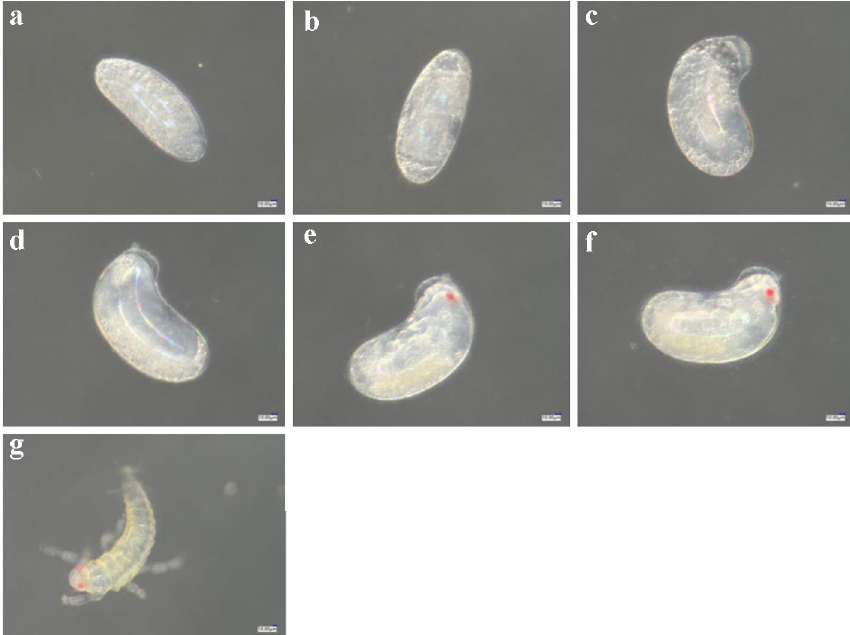
Figure 10. The embryonic development process of control 0-h-old eggs of F. occidentalis . ( a ) Control initial eggs; ( b ) eggs after 12 h of development; ( c ) eggs after 24 h of development; ( d ) eggs after 36 h of development;